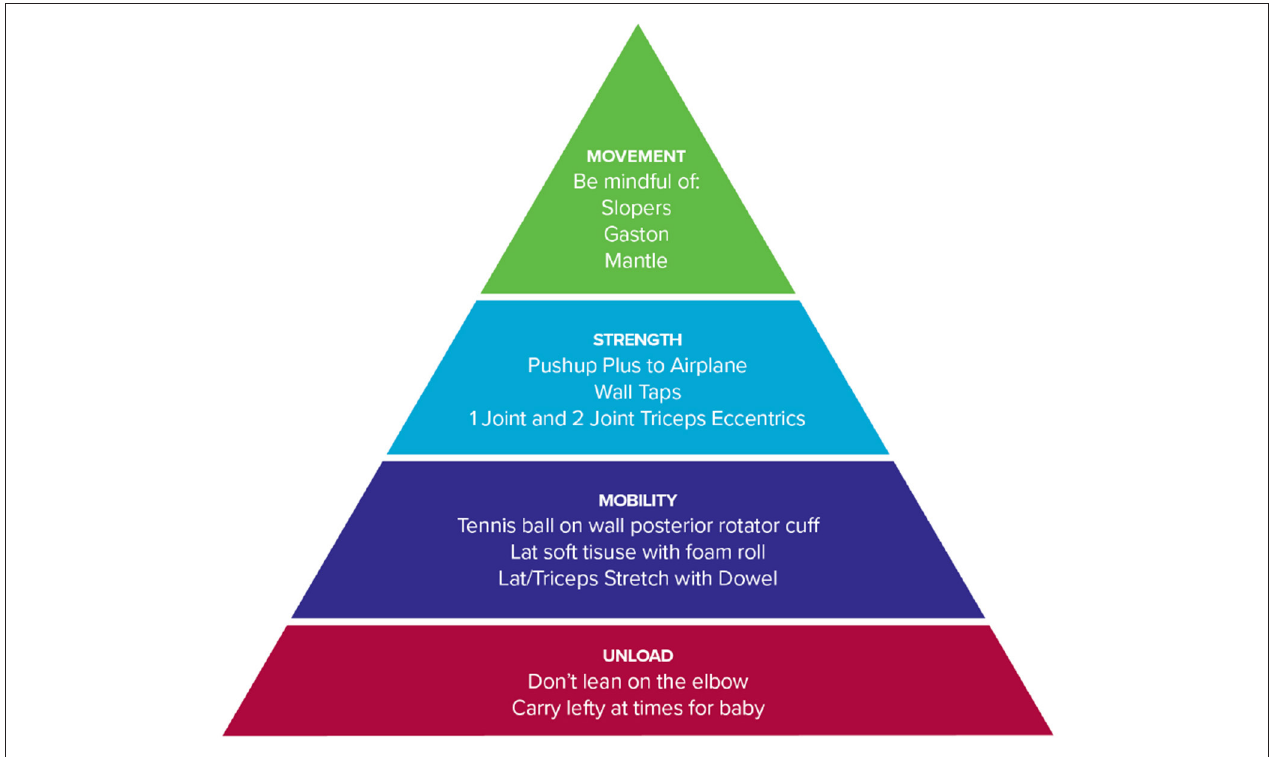
FIGURE 3 | Organization of rehabilitation into a framework.